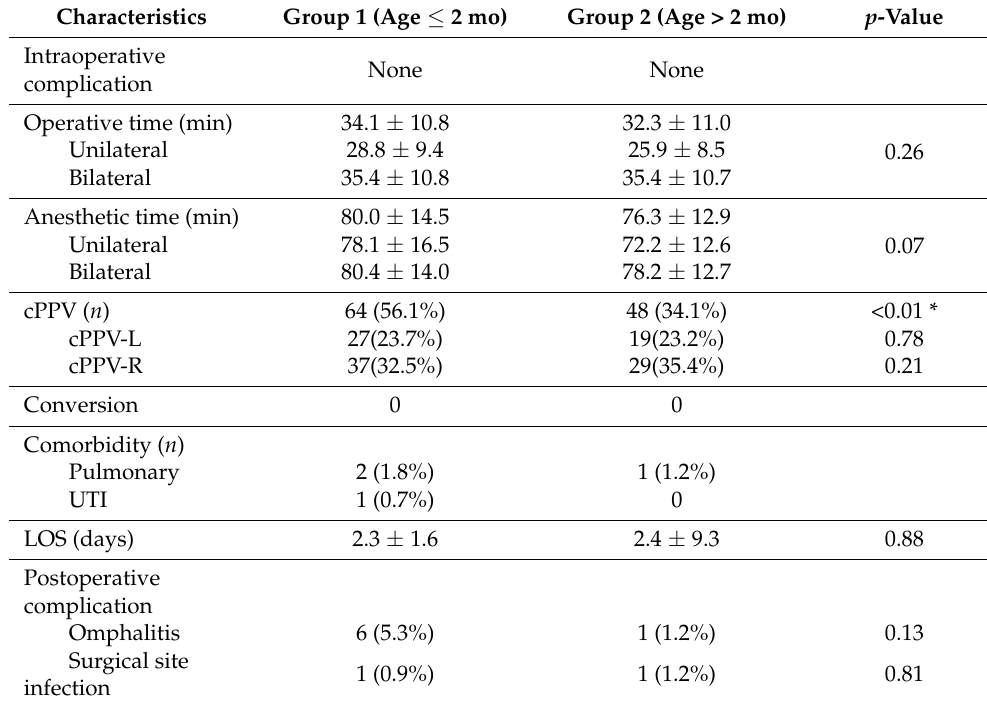
Table 2. Intraoperative and postoperative